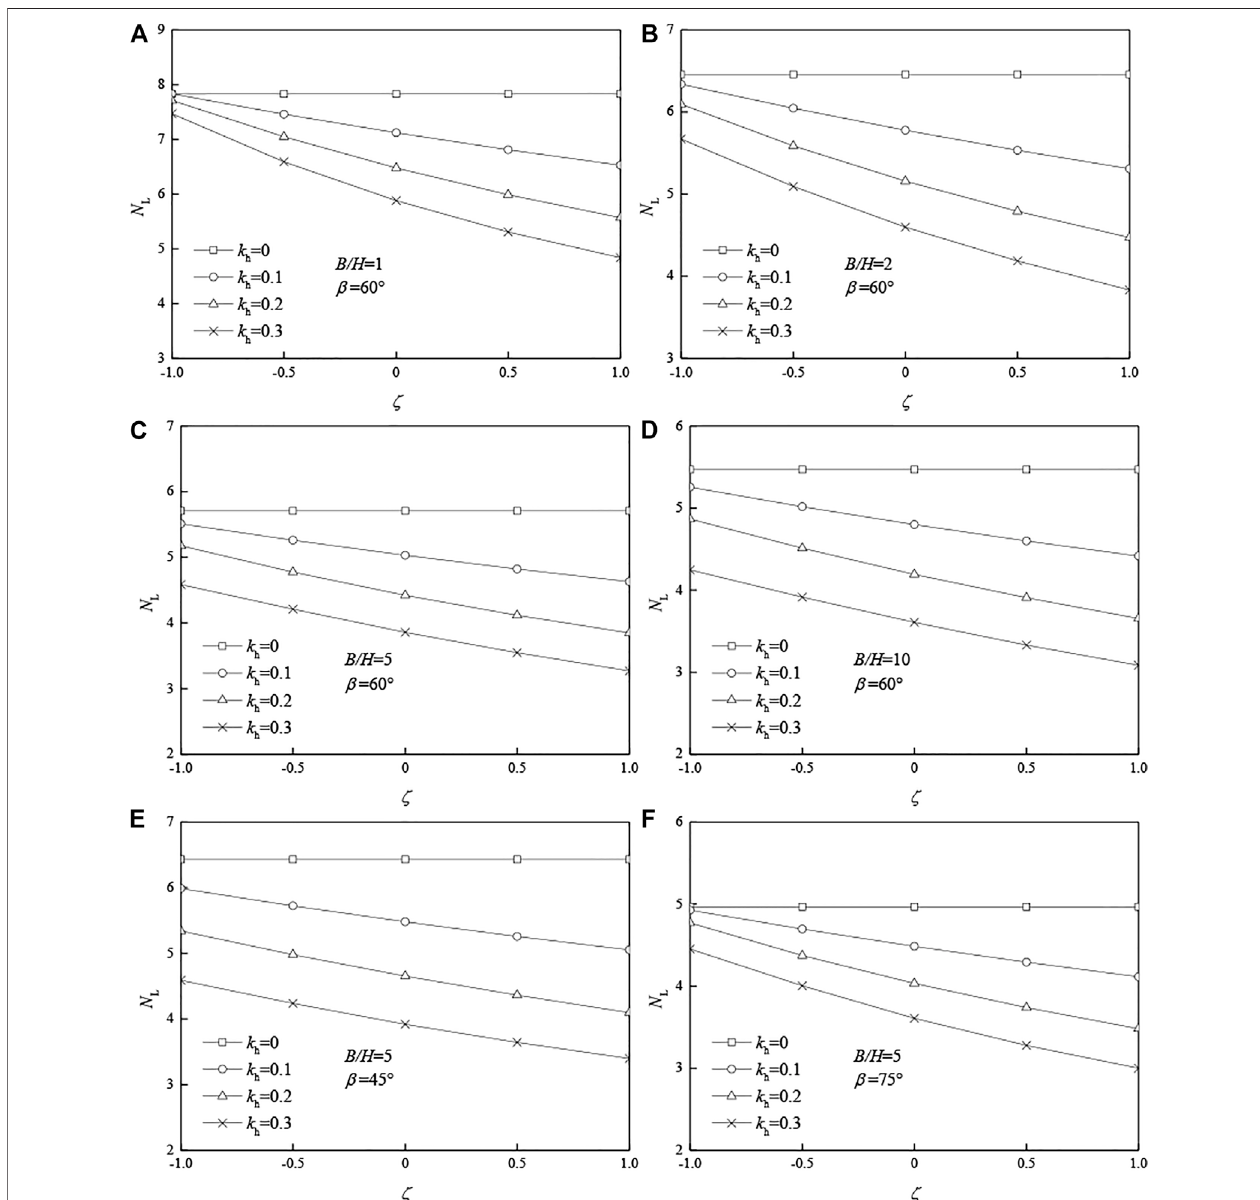
FIGURE 5 | Effects of the vertical seismic effect proportion coef fi cient ζ on stability factor N L . (A) B/H (cid:1) 1, β (cid:1) 60 ° ; (B) B/H (cid:1) 2, β (cid:1) 60 ° ; (C) B/H (cid:1) 5, β (cid:1) 60 ° ; (D) B/H (cid:1) 10, β (cid:1) 60 ° ; (E) B/H (cid:1) 5, β (cid:1) 45 ° ; (F) B/H (cid:1) 5, β (cid:1) 75 ° .